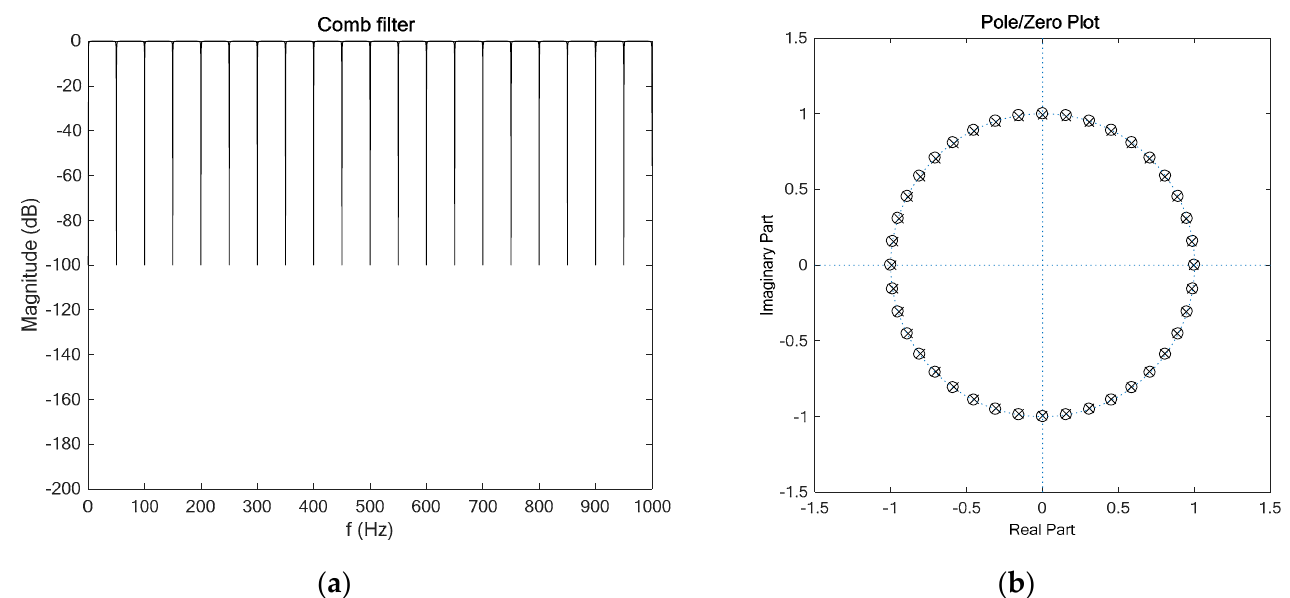
Figure 11. Comb filter, ( a ) magnitude for M = 40 and Δ f = ± 0.5 Hz, ( b ) poles and zeros distribution on the z-plane for comb filter.